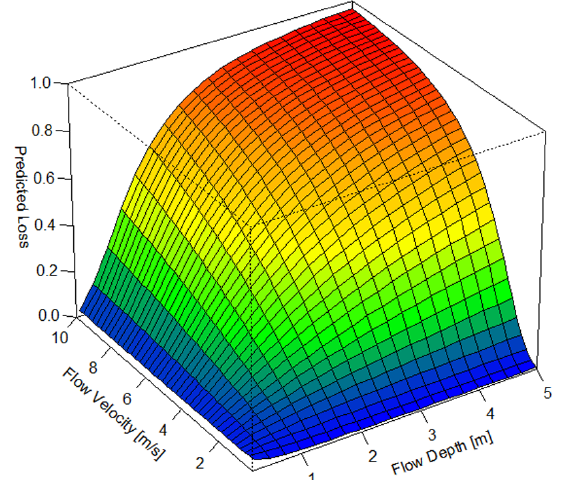
Fig. 3. Proportional loss predictions by Model I for commonly ob- served debris flow depths and velocities. To construct this plot, the impact angle was fixed at the sample means of 64 ◦ .